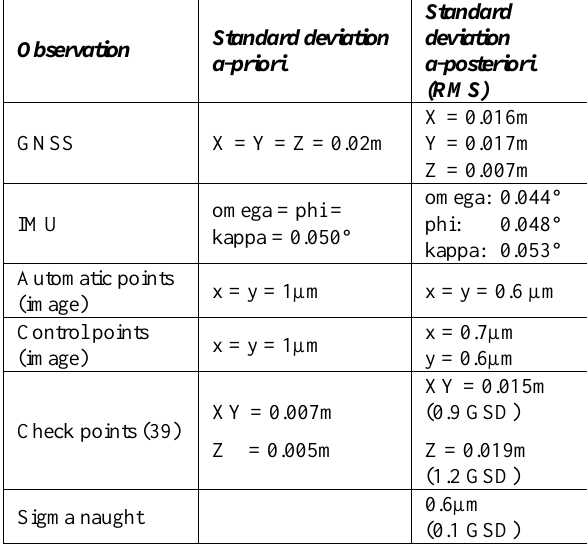
Table 4: Results of AT without control points